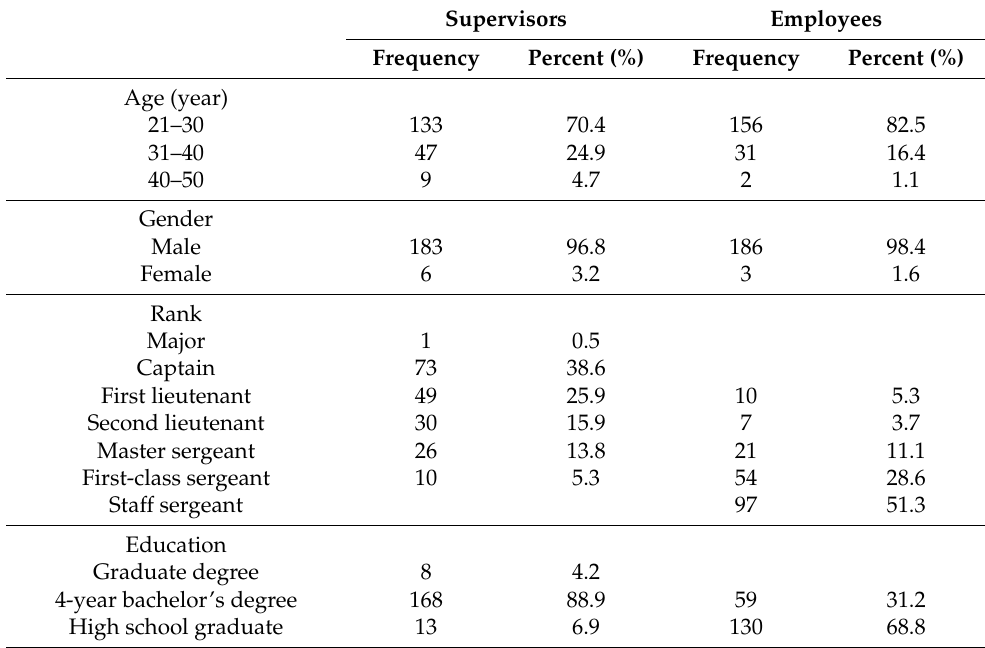
Table 1. Demographic